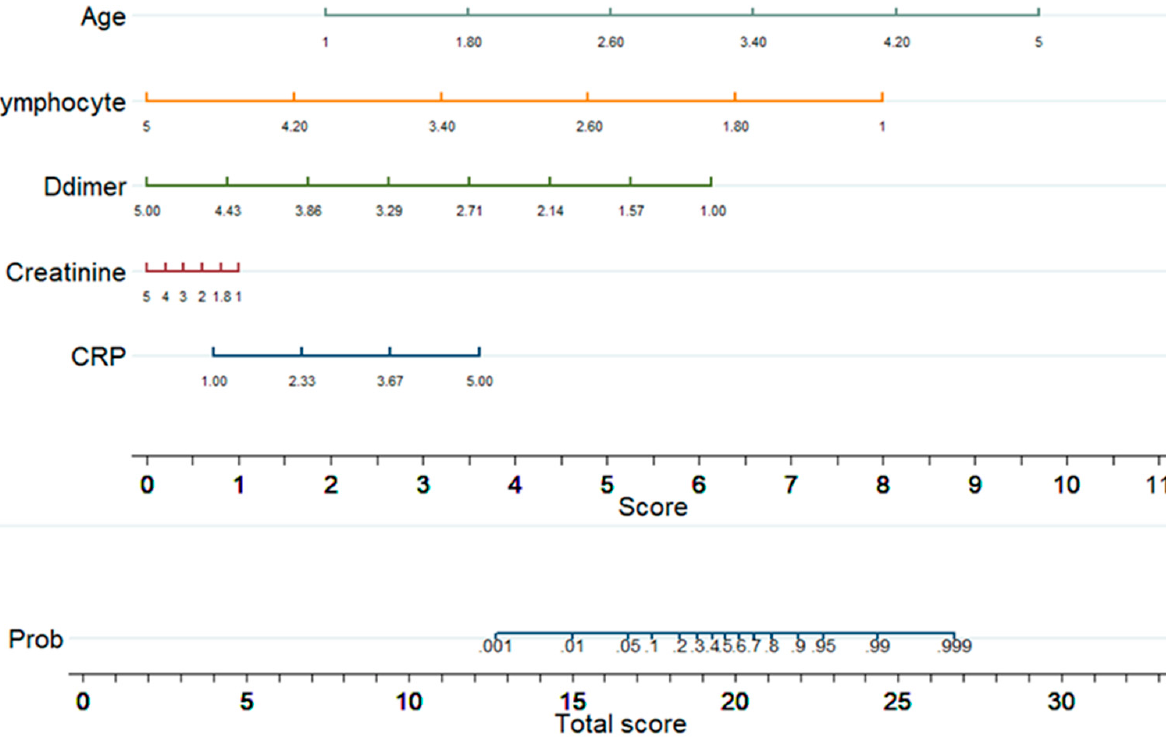
Figure 4. Internal Validation Curve ( A , B ) and the External validation ( C ).